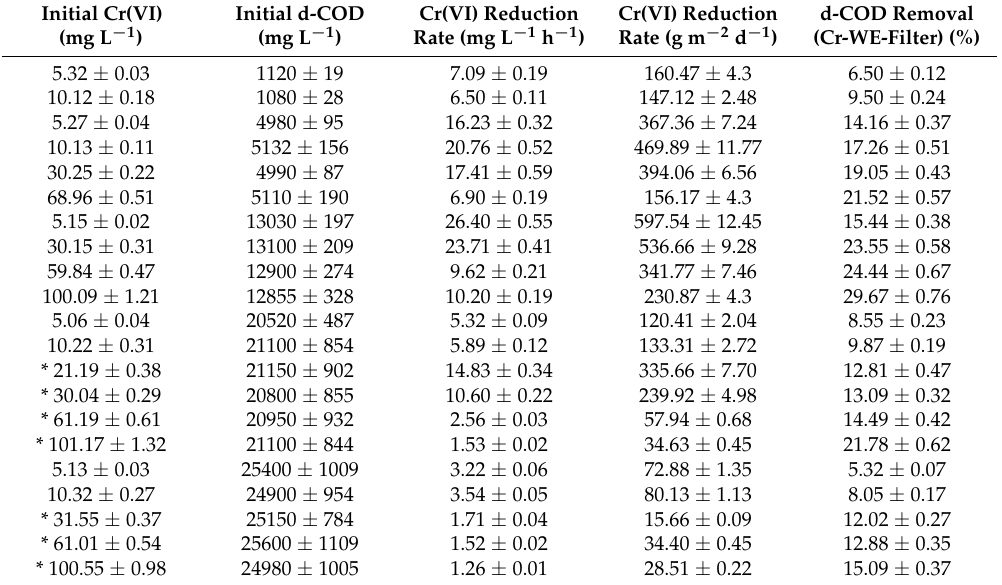
Table 4. Cr(VI) reduction and d-COD removal rates for the different initial Cr(VI) and d-COD concentrations tested in the Cr-WE-filter operating under SBR with a recirculation rate of 1.0 L min − 1